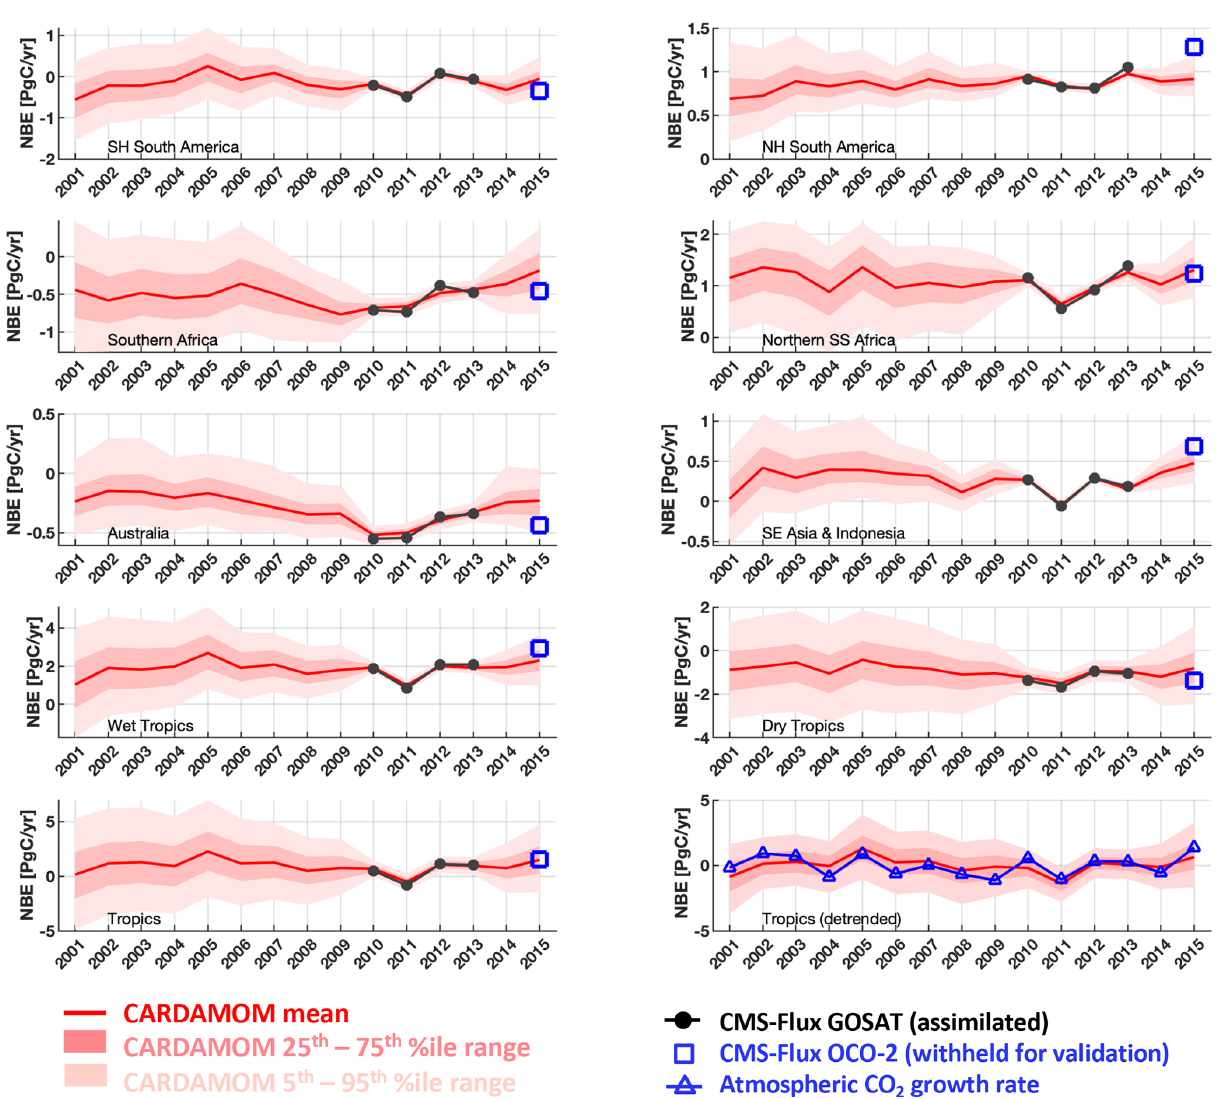
Figure 5. CARDAMOM yearly analyses of 2001–2015 NBE (red line) and associated uncertainty intervals (25th–75th percentiles in dark pink and 5th–95th percentiles in light pink). The analyses were constrained by CMS-Flux GOSAT-derived top-down fluxes (Liu et al., 2018) for the 2010–2013 period. CMS-Flux OCO-2-derived 2015 NBEs (blue squares) are withheld for regional and pan-tropical NBE validation. CARDAMOM NBE and NOAA ESRL atmospheric CO 2 growth rates were detrended for inter-comparison (bottom-right panel). The geographical definitions for each region are shown in Fig.